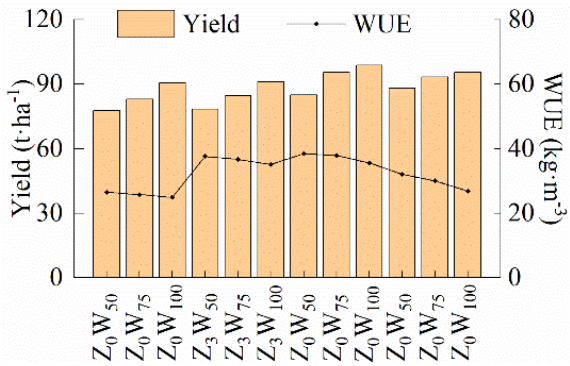
Figure 5. Effects of W ‐ Z on tomato yield and WUE during alternate drip irrigation under mulch.